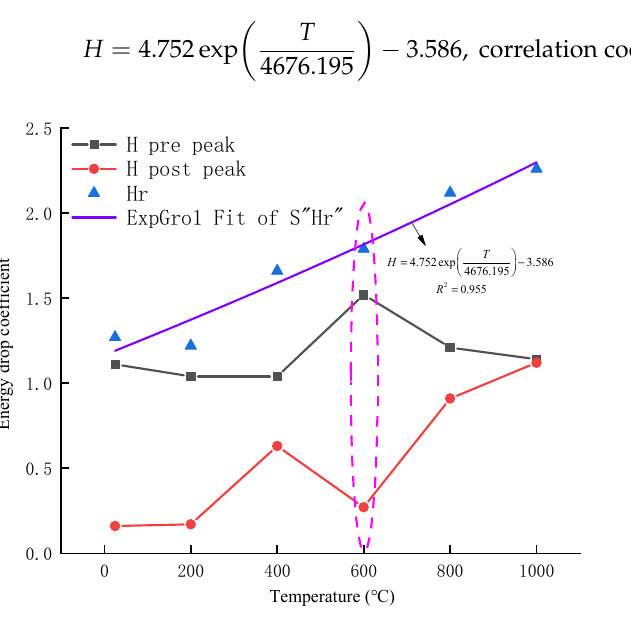
Figure 7. Energy drop coefficient with temperature.